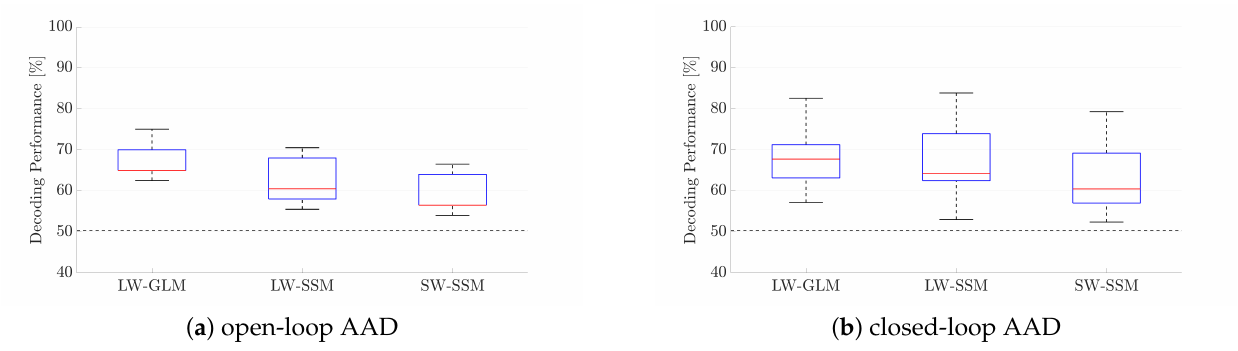
Figure 6. Decoding performance for ( a ) the open-loop AAD phase and ( b ) the closed-loop AAD phase when using the LW–GLM, LW–SSM, and SW–SSM algorithms. The boxplots display the median, the first quartile, the third quartile, the minimum, and the maximum of the decoding performance across participants. The dashed-line represents the upper boundary of the confidence interval corresponding to chance level based on a binomial test at the 5% significance